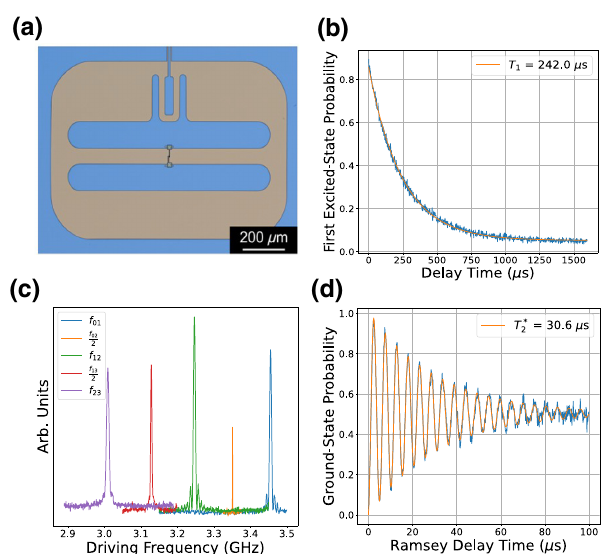
FIG. 1. Planar tantalum transmon. (a) False-color optical image of differential transmon device, courtesy of [ 26]. In blue are the tantalum capacitor pads, ground plane, and coupling to the readout resonator. The Josephson junction connecting the two capacitor paddles is aluminum. (b). For this particular device we consistently measure energy relaxation times in the qubit sub- space of 247 ± 9 μ s. (c). Shown are spectroscopy measurements of the qudit levels we make use of in this work. (d). Ramsey mea- surement in the qubit subspace yield T 2 * of approximately 30 μ s, depending on